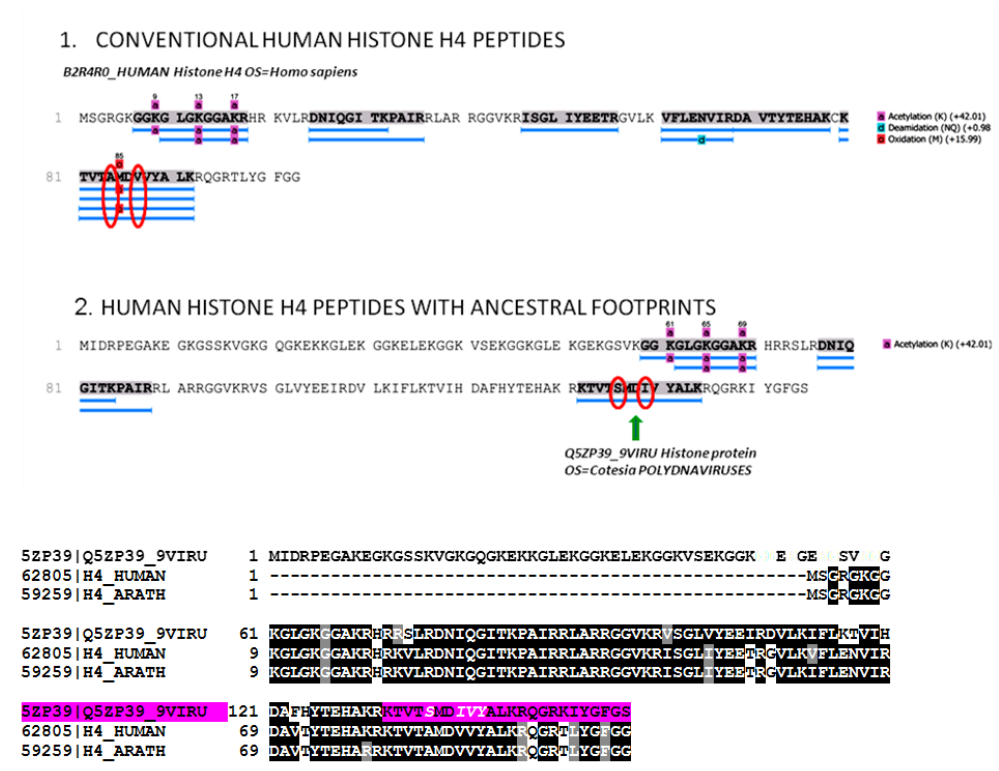
Figure 11. PEAKS Coverage view of the histone H4 peptides searched against the combined human-virus database, 1% of FDR. Section 1: The identified peptides are the canonical human histone-4 isoforms. Section 2: The histone H4 peptide KTVSMDIVYALK, indicated by the green arrow, has a unique footprint not found in any human or other eukaryotes proteins. This peptide displays the same unique sequence found in the C-terminus of the histone H4 of giant polydnaviruses (purple colour in the alligmnements between eukaryotes and polydnaviruses histone H4 sequences).